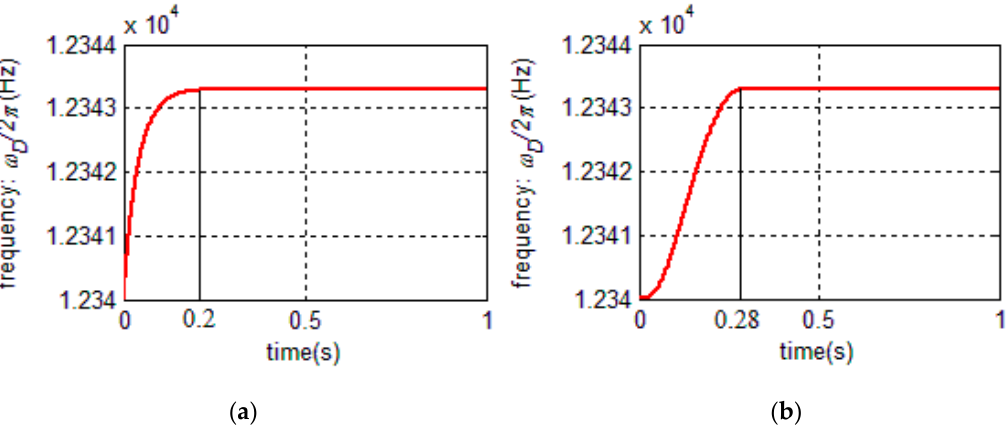
Figure 16. ( a ) Step response of the PLL linearized model and ( b ) step response of the PLL original model.